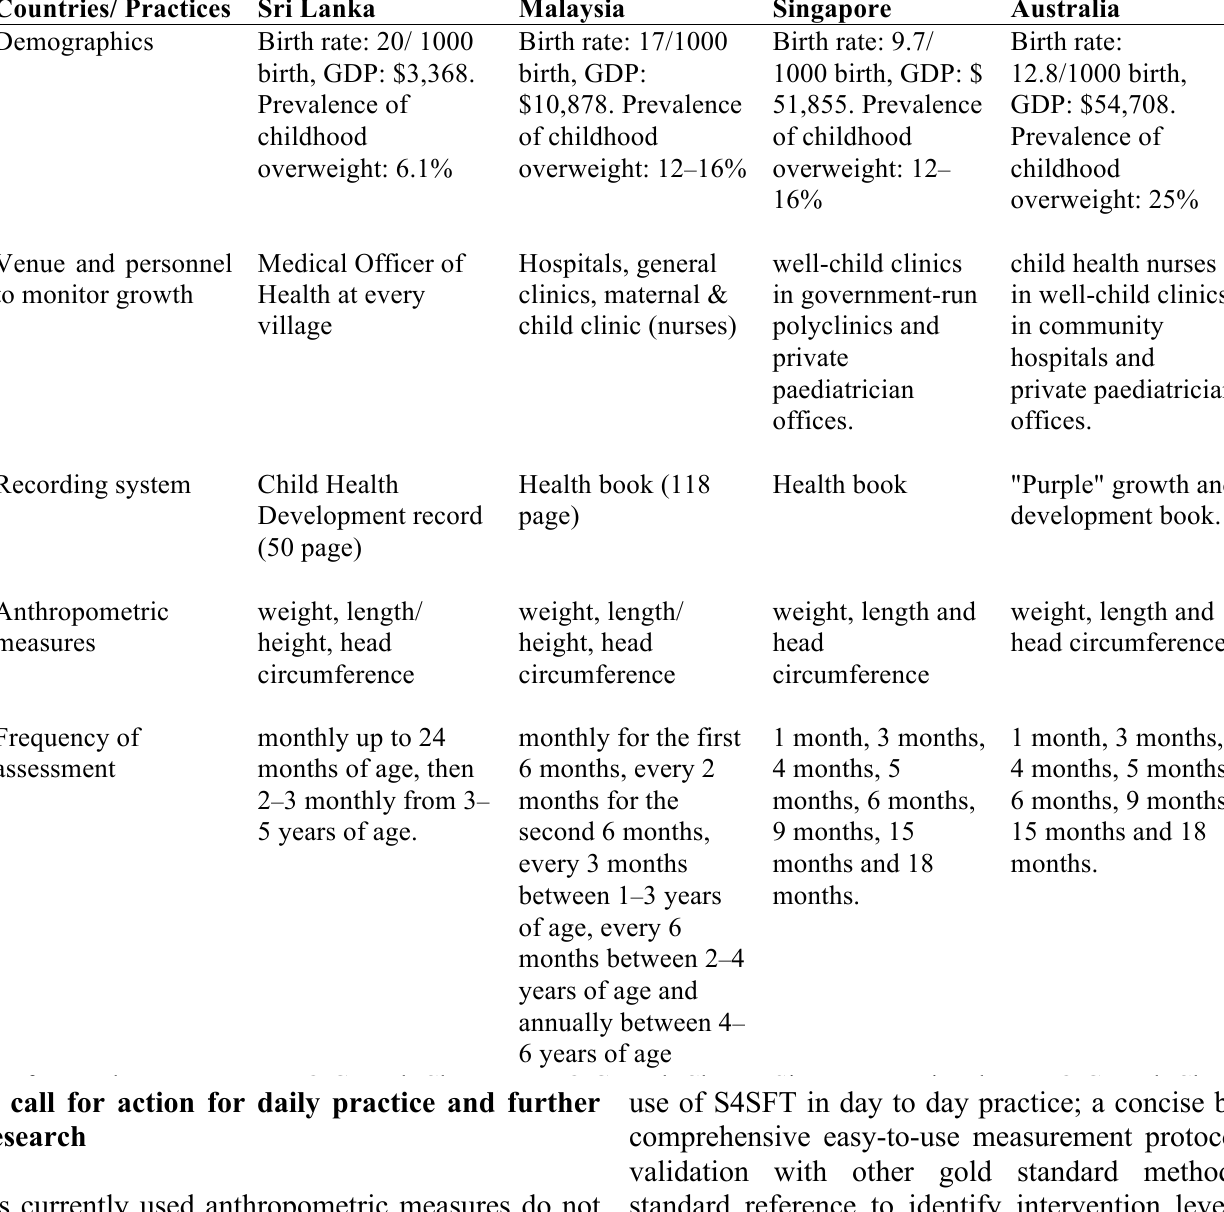
Table 1. Overview of current practices for growth monitoring among children 0-5 years of age across the four